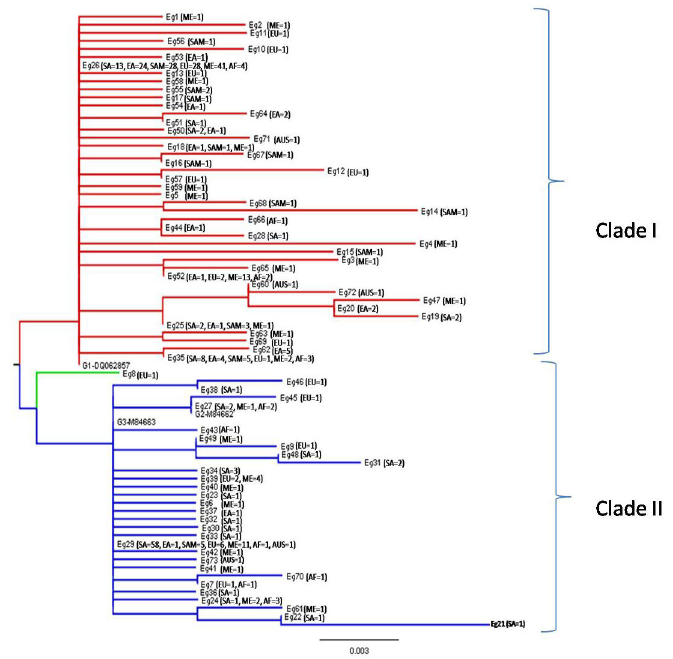
Figure 1. Dendrogram constructed from the coxI sequences of E. granulosus isolates analysed in the present study along with those retrieved from GenBank. The 369 gene sequences are clustered in 73 haplotypes (Eg1-Eg73). SA: South America; EA: East America; EU: Europe; ME: Middle East; AF: Africa; SAM: South America; AUS: Australia.